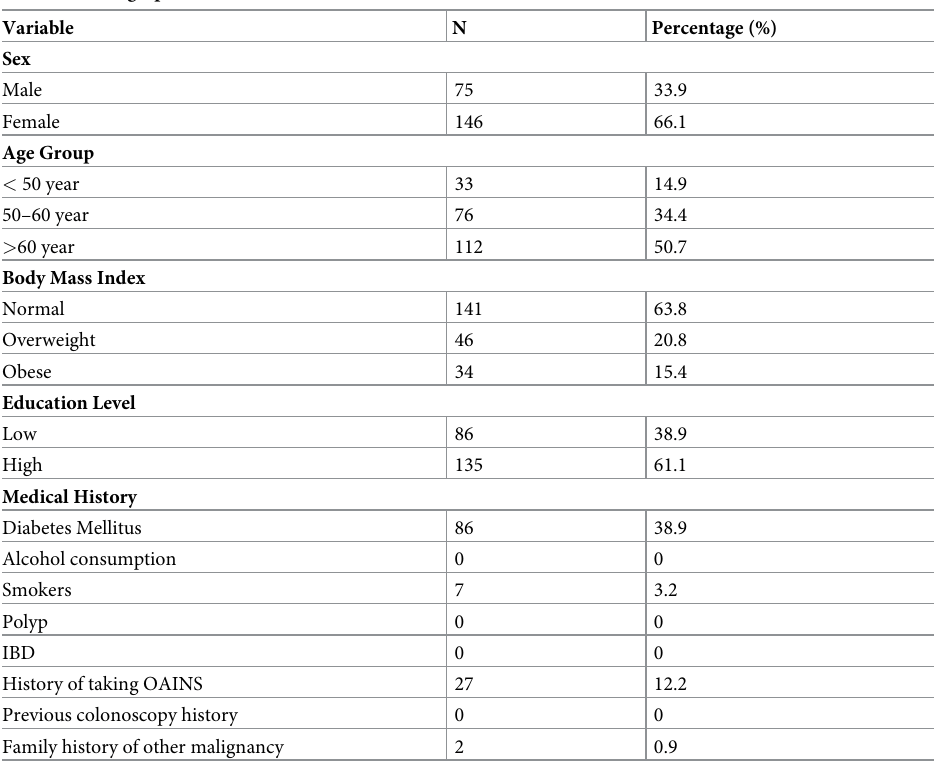
Table 2. Demographic